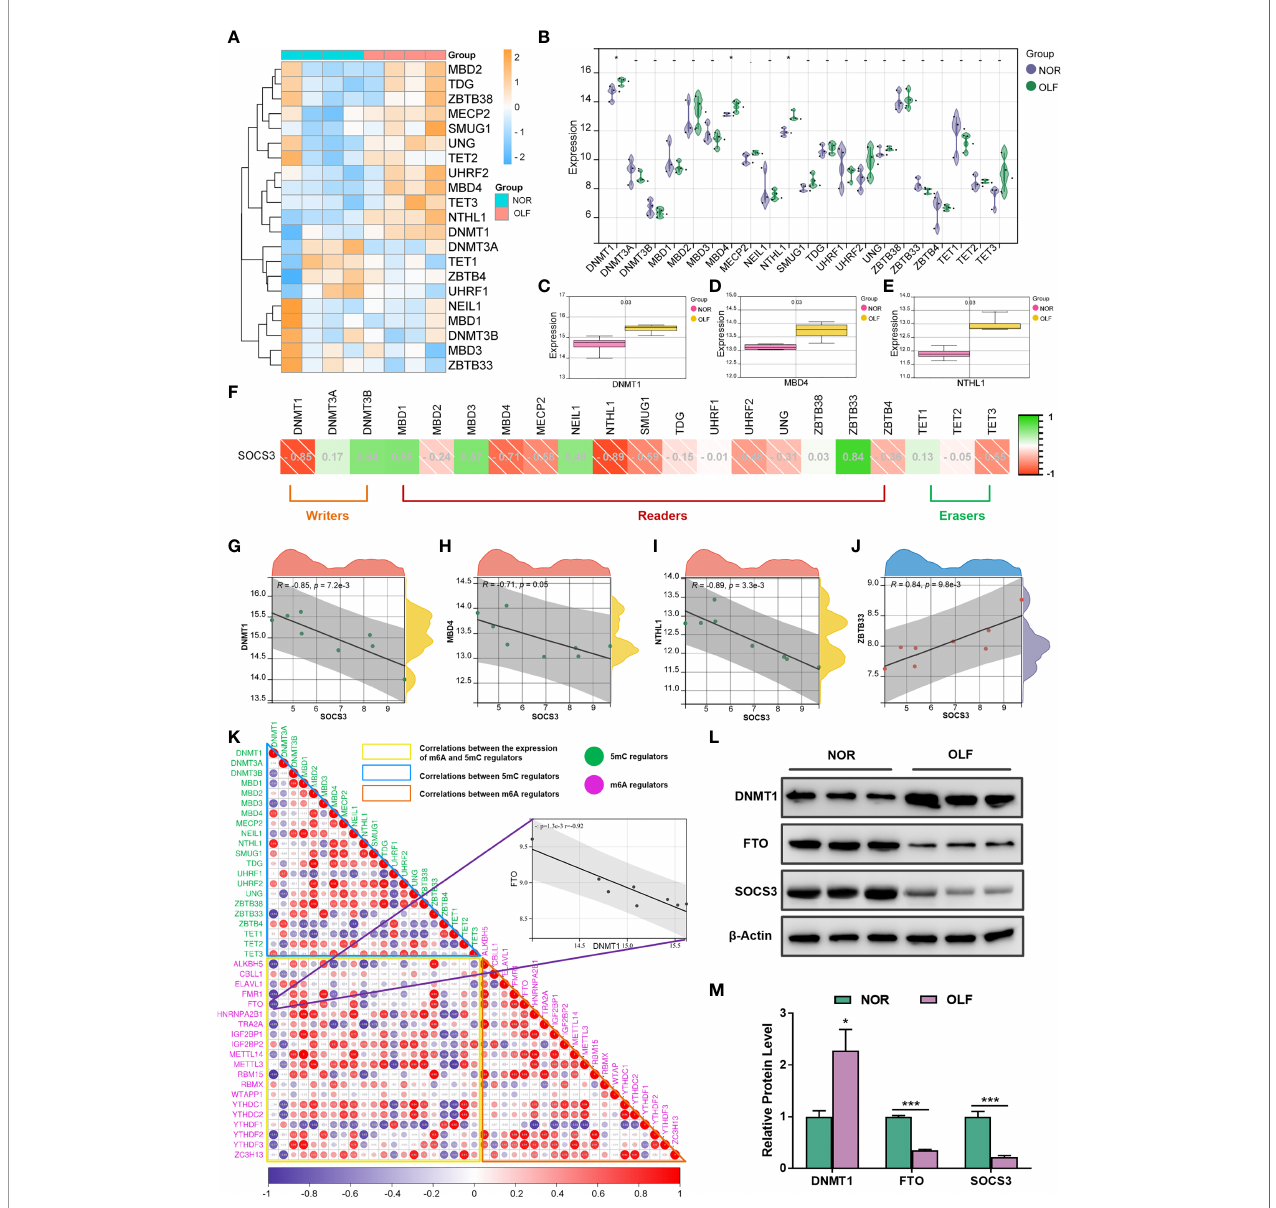
FIGURE 9 | Correlation analysis of SOCS3 and 5mC regulators in OLF. (A) Heatmap of 21 5mC regulators in OLF. (B) Volcano plot showing the expression of 21 5mC regulators in OLF. (C) Box plot showing three differentially up-regulated DNMT1 in OLF. (D) Box plot showing three differentially up-regulated MBD4 in OLF. (E) Box plot showing three differentially up-regulated NTHL1 in OLF. (F) Correlation heatmap between SOCS3 expression and 21 5mC regulators. (G) SOCS3 expression was signi fi cantly negatively correlated with DNMT1. (H) SOCS3 expression was signi fi cantly negatively correlated with MBD4. (I) SOCS3 expression was signi fi cantly negatively correlated with NTHL1. (J) SOCS3 expression was signi fi cantly positively correlated with ZBTB33. (K) Correlation heatmap between the expression of m6A and 5mC regulators, and DNMT1 had a strong negative correlation with FTO. (L, M) The protein level of FTO and SOCS3 were signi fi cantly down-regulated while the protein level of DNMT1 was signi fi cantly up-regulated in OLF samples compared to controls. *p < 0.05, ***p <